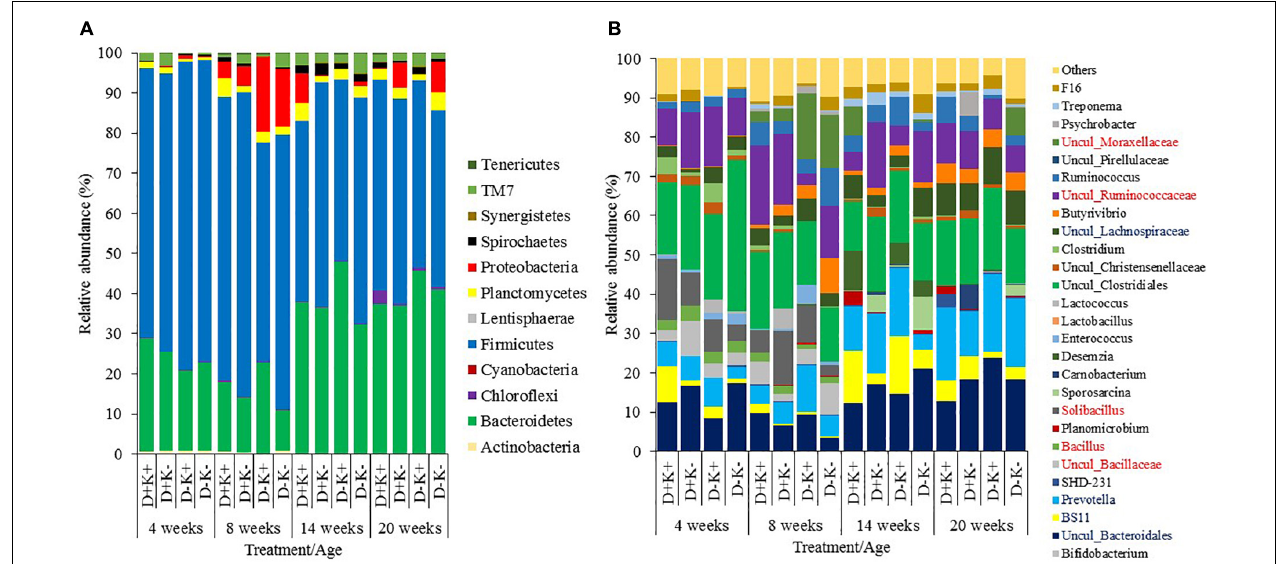
FIGURE 2 | Relative abundance of rumen bacteria (%) in goat kids at phyla (A) and genus (B) level (relative abundance > 1%) of goat kids at 4, 8, 14, and 20 weeks of age. Genera presented in the legend in blue or red font, indicate higher abundance at older or younger ages, respectively. Although the genera Solibacillus, Bacillus, Uncul_Bacillaceae were significantly higher in weeks 4 and 8 compared to weeks 14 and 20, this could not be visualized in weeks 14 and 20 due to too limited abundance.